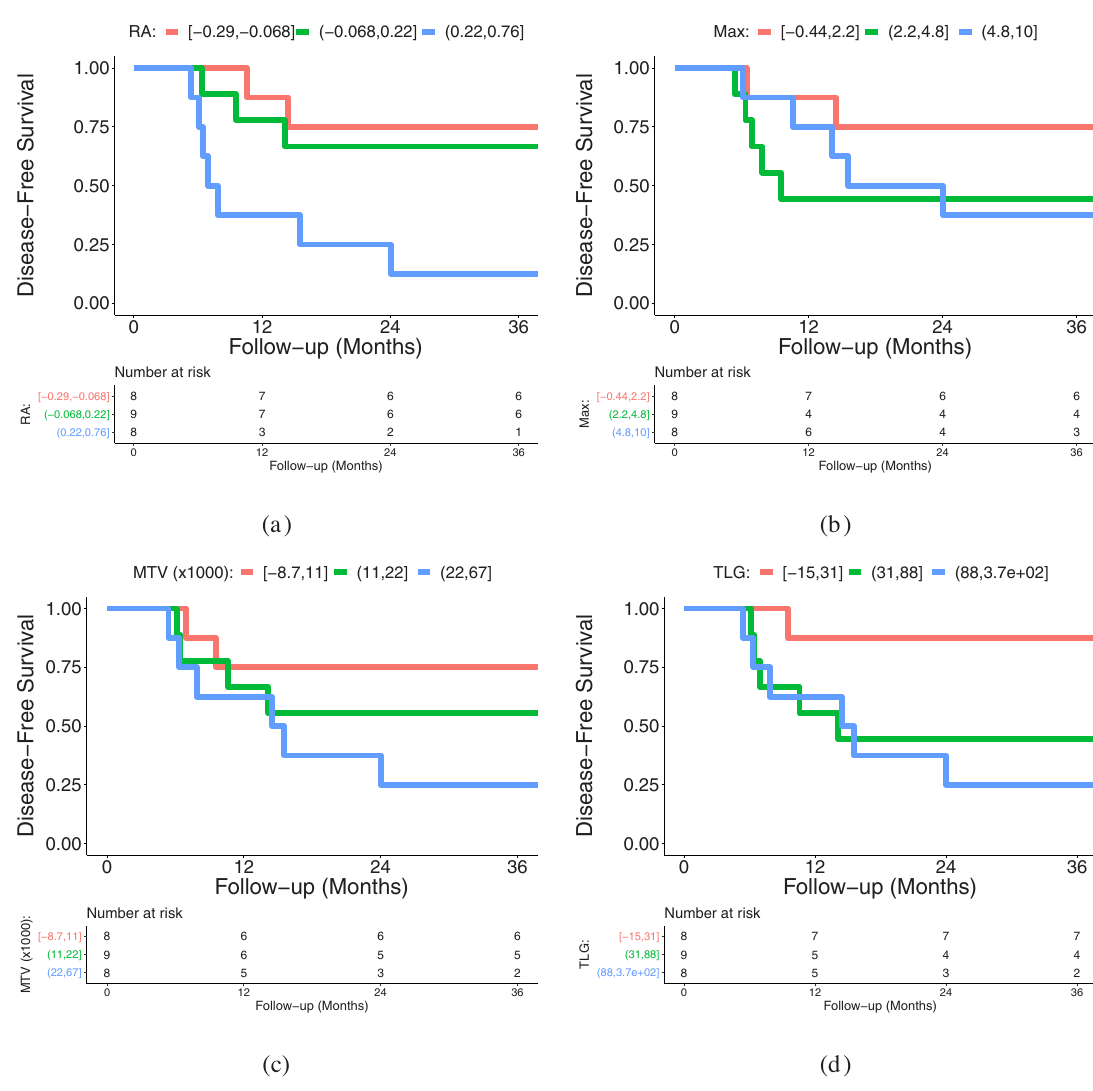
Fig 2. Kaplan-Meier plot of disease-free survival for patients stratified into low, intermediate, and high groups of post-treatment change in RA in image feature using tertiles. (a) Plot for RA. (b) Plot for Max. (c) Plot for MTV. (d) Plot for TLG.